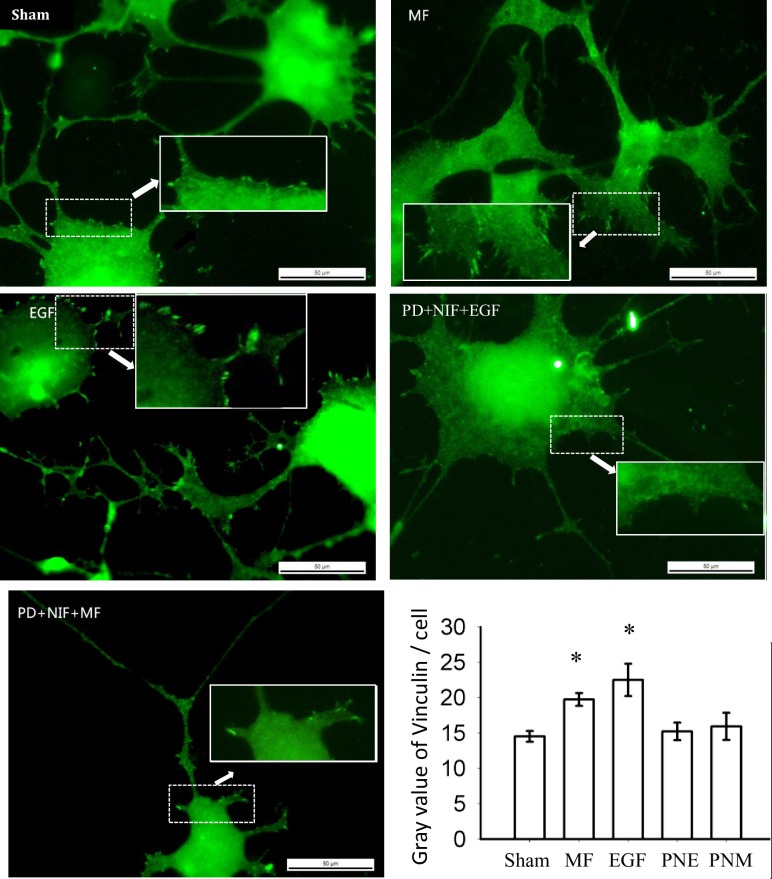
MF induced more focal adhesion in PC12 cells periphery.The groups were treated as described in Fig 1 and in Materials and Methods. The parts in dashed square were further amplified 2x, as indicated by the arrows. The horizontal bar represents 50 μm. The average gray value / content of vinculin per cell was quantified for each group within at least 50 cells (see details in S1 Table) and was shown in the histogram; *: p-value < 0.05 when compared with Sham by student’s t-test.